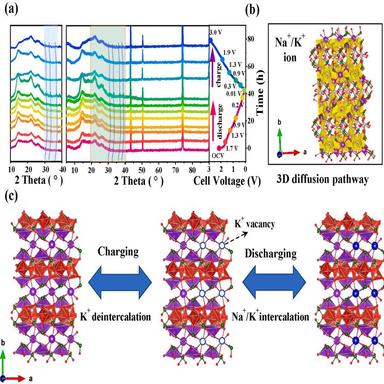
Exsitu-XRD pattern of KVP-HD electrode during the initial charging/discharging: (a) exsitu-XRD curve and its enlarged selected diffraction area; (b) 3D Na+/ K+ ion diffusion pathway in the polyanionic structure; (c) schematic structure variation of KVP-HD electrode during charging/discharging.